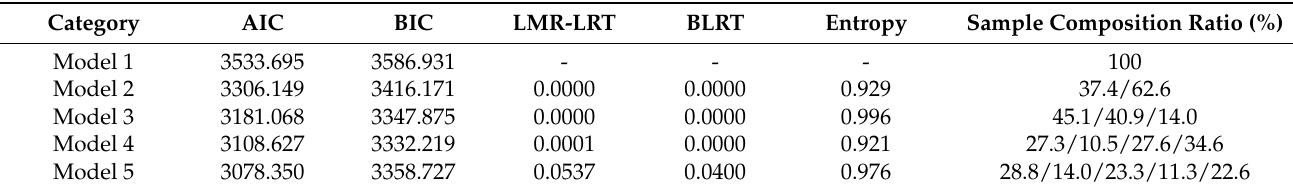
Table 4. Fitting test results of each potential category model ( n =